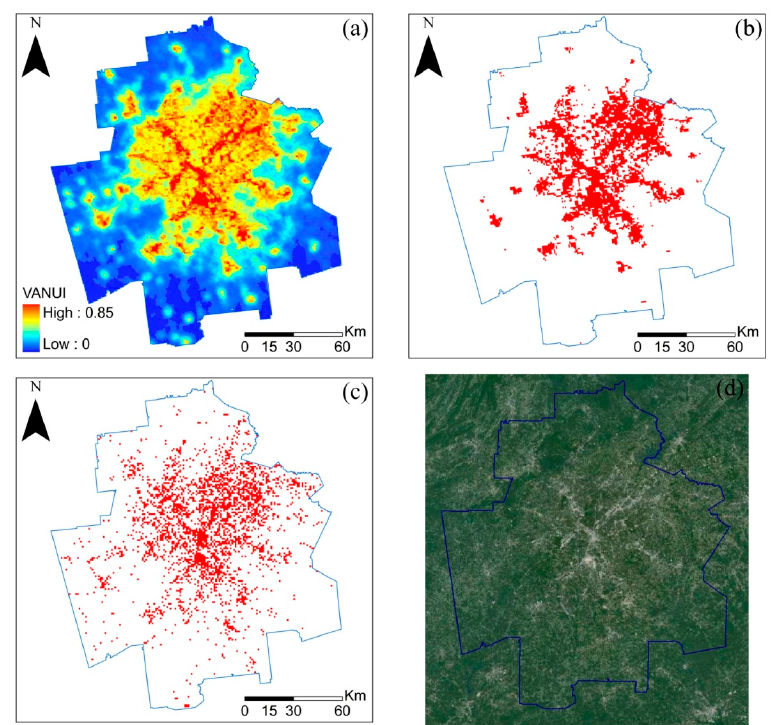
Figure 5. Urban area detection in the Atlanta metropolitan area: ( a ) VANUI data; ( b ) urban extent mapped from VANUI data; ( c ) urban extent from NLCD 2011 land cover product; and ( d ) Google Earth image.